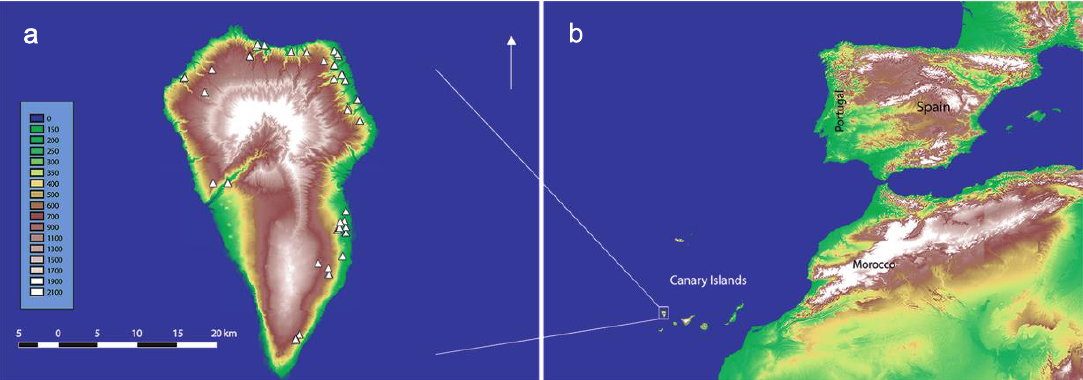
Figure 1. Elevation map of La Palma showing the spatial distribution of the peach trees sampled (white triangles) ( a ). Geographical localization of Canary Islands and La Palma ( b ).